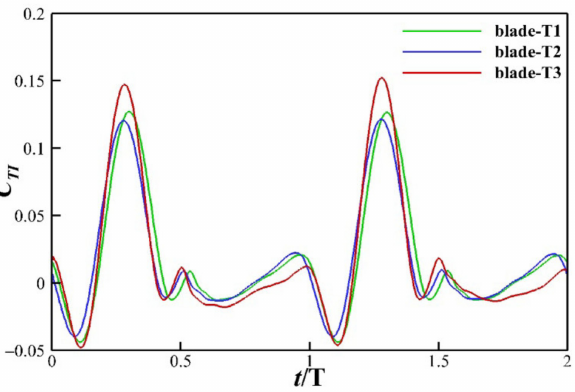
Figure 20. Comparison of instantaneous torque coefficients of a blade over two cycles ( L =